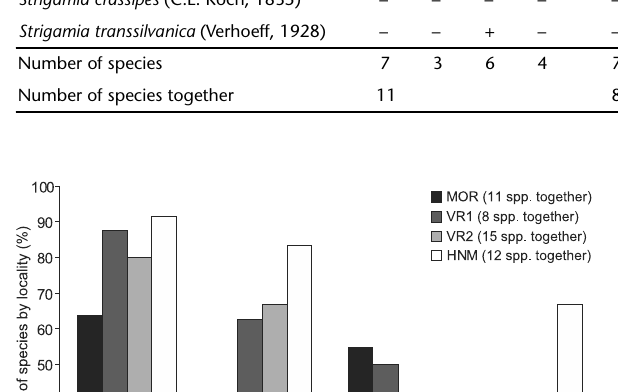
Soil Pitfall Litter Hand sampling trapping sifting